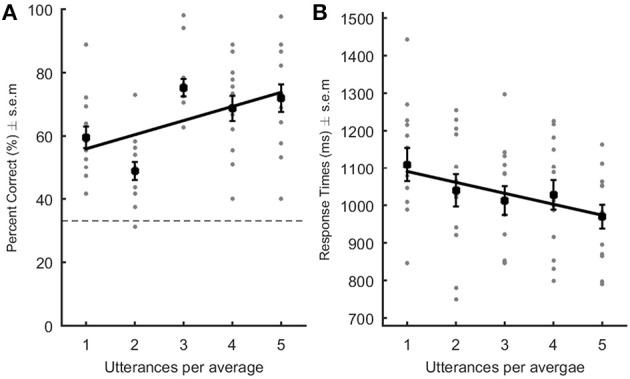
Performance in the recognition of famous voices. Percent correct (A) and response times (B;ms) are represented as a function of the level of averageness (i.e., number of utterances per voice average). Gray dots represent each participant's data point. The black square represents the average performance across listeners. In (A), the dotted line indicates chance level. Black lines: linear regression built using the average slope and intercept values obtained after performing the linear regression in each and every subject. For famous voices, performance increased and RTs decreased significantly with increasing number of utterances per average.